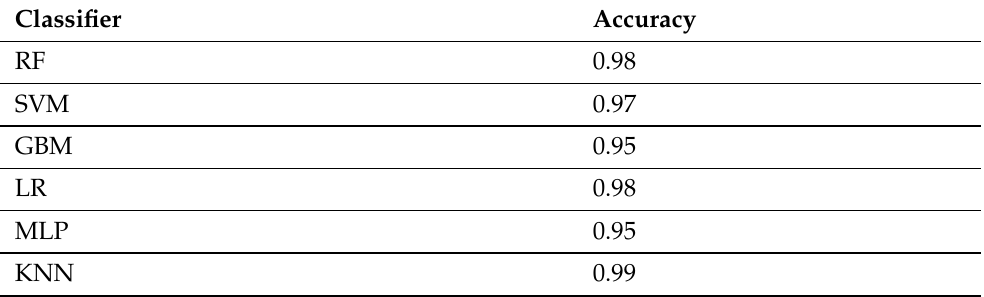
Table 10. Experiment results using all 30 features from the balanced